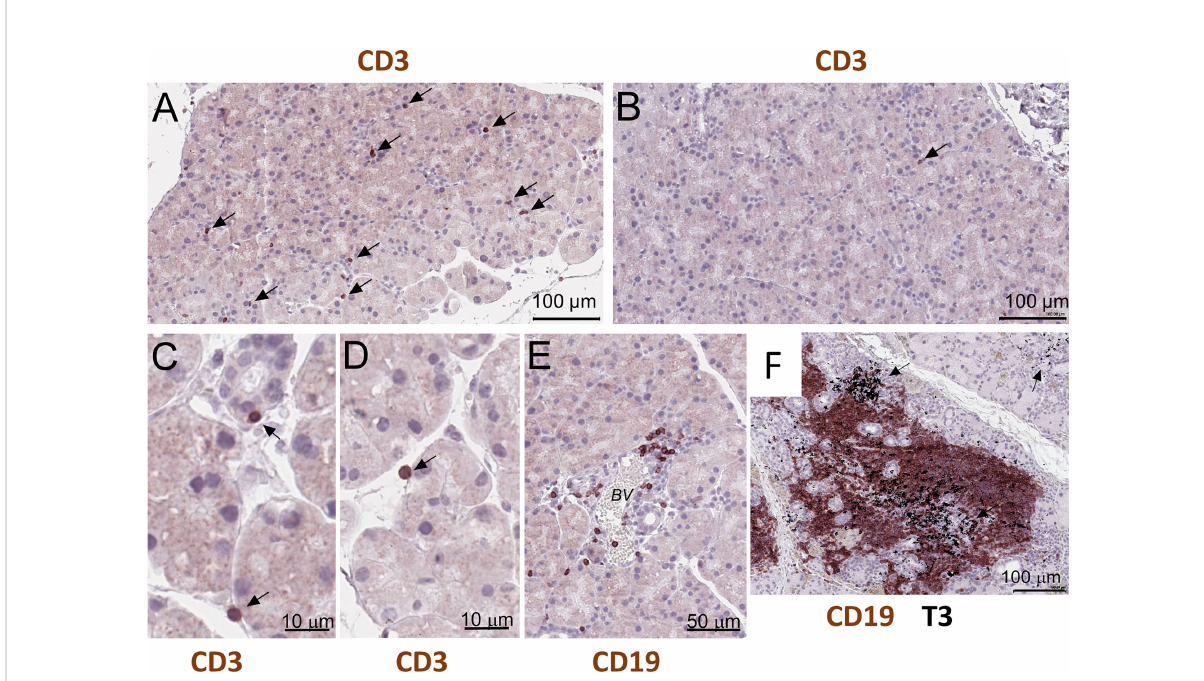
FIGURE 5 Histological validation of visium alteration. Analysis of T and B cells in the LG of the NOD.H-2b mice. (A – D) CD3 + cells in the LG of the 2 months old male penetrate throughout tissue and appeared to be attached to duct and acini (black arrows), whereas (B) in control BALB/c mice CD3 + cells are rare (B, black arrow). (E) Later at 3 months of age B cells (stained with the B220 or CD19 antibody) concentrate within an interductular space near the blood vessels (BV). (F) Double immunostaining of LG paraf fi n section with B220 (brown - B cell marker) and T3 (black – T cell marker, black arrows) showing that majority of cells within in fi ltrate are B cells. B and T cells are organized into an ectopic lymphoid